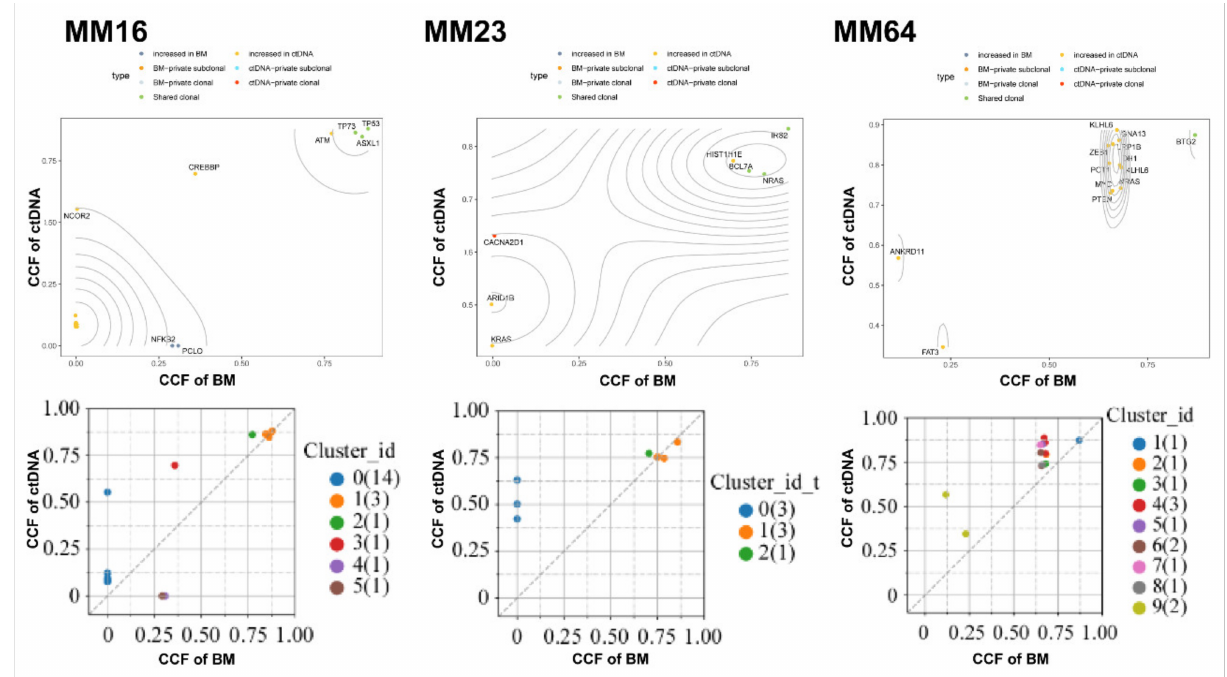
Figure 2. Representative genomic architecture derived from paired ctDNA versus BM DNA. Cancer Cell Fraction (CCF) of mutations was calculated in ctDNA and BM DNA. Each dot represents one mu- tation, and the color of each dot indicates the subclone that the given mutation was clustered